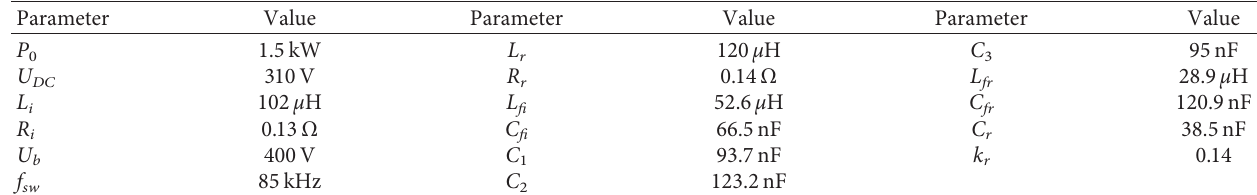
Table 2: System and compensation circuit